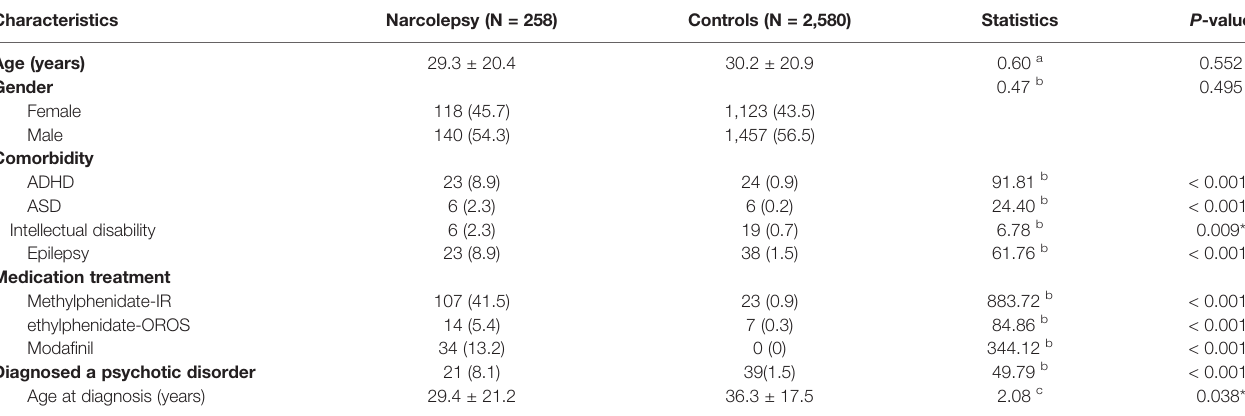
TABLE 1 | Characteristics of patients with narcolepsy and control subjects in Taiwan from 2002 to 2011.